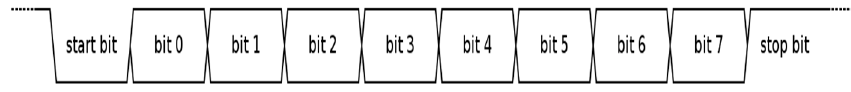
Figure 2. Example universal asynchronous receiver-transmitter (UART) data format.